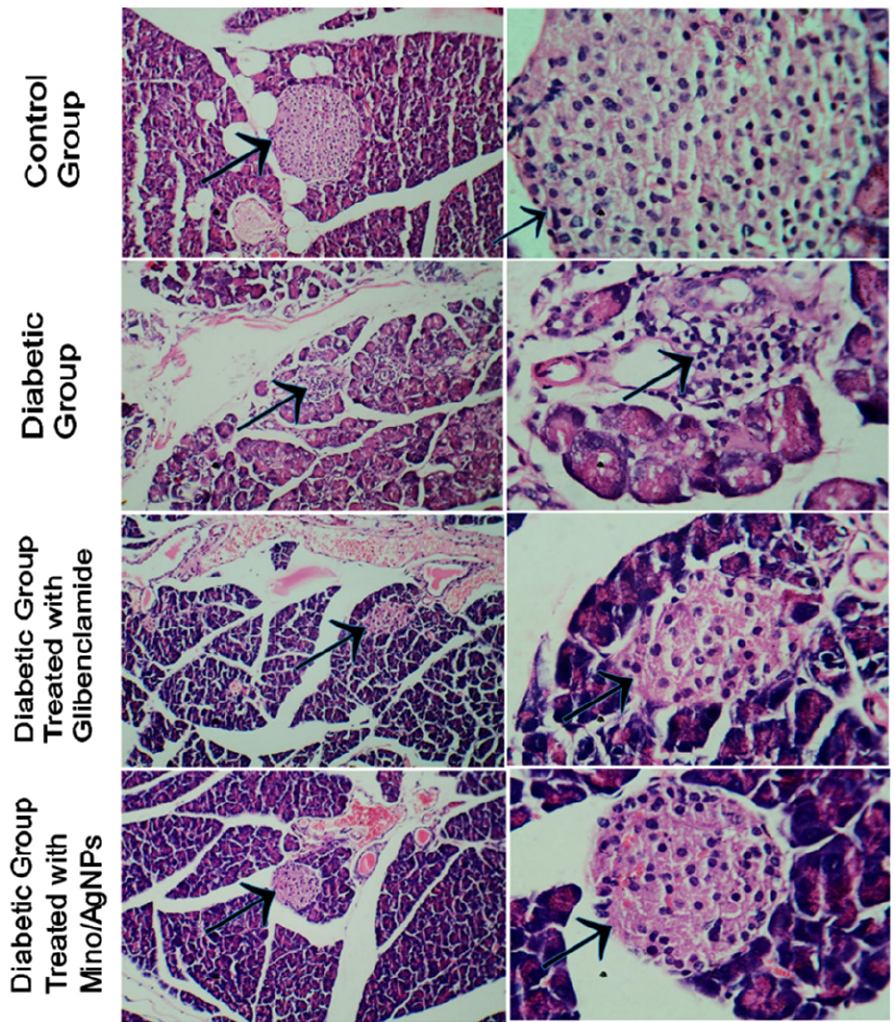
Figure 11. Histopathology of the islet cells of pancreatic sections of various study groups (arrowhead pointing towards the islet tissue of pancreas).